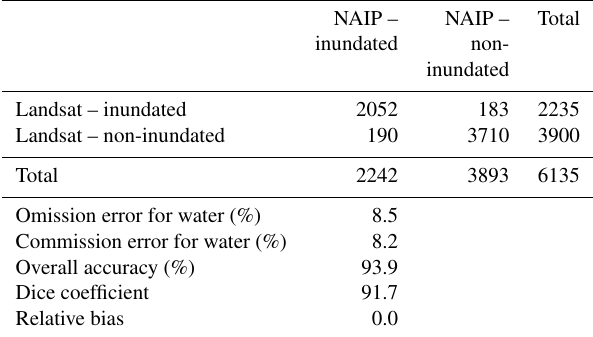
Table 3. Summary of accuracy statistics across all of the Land- sat images validated using National Agricultural Imagery Pro- gram (NAIP)